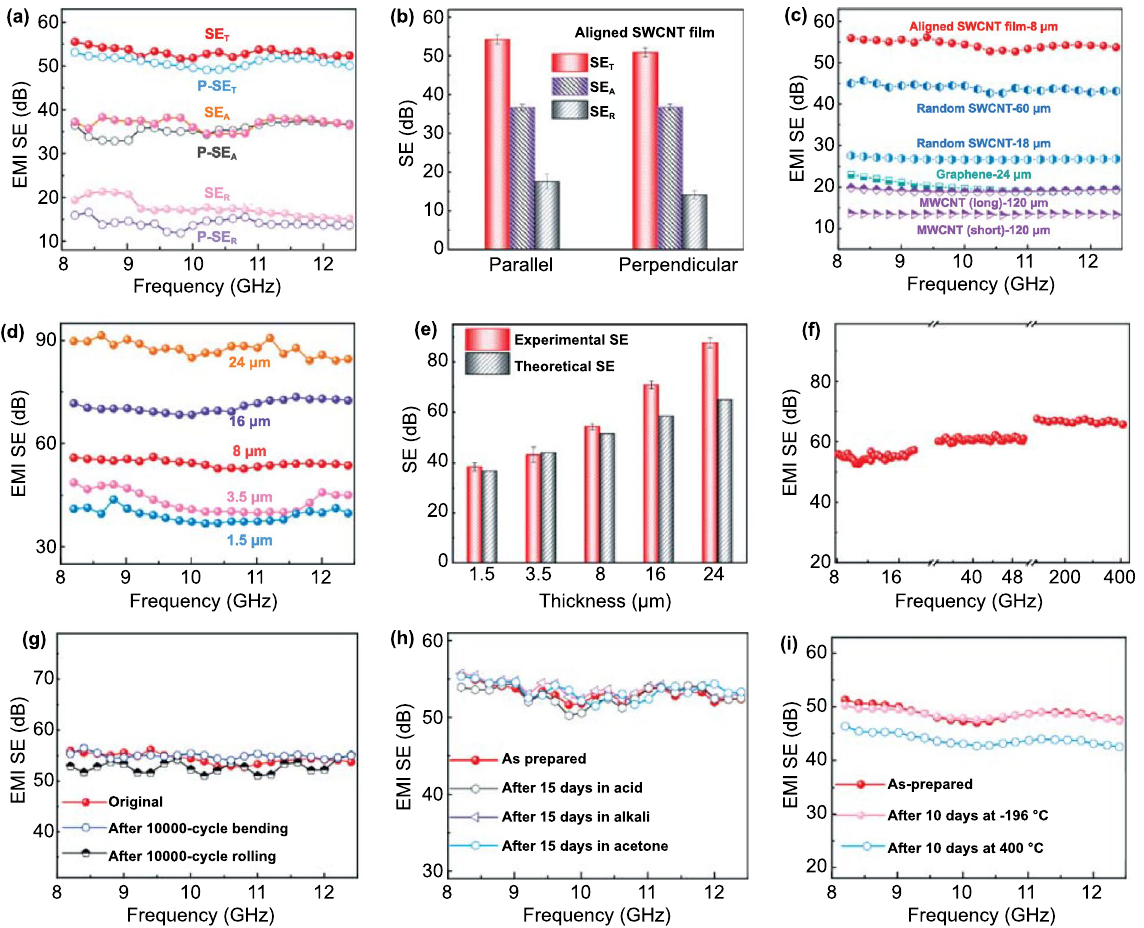
Fig. 3 EMI shielding performance of the aligned SWCNT films. EMI Shielding performance a in the X-band and b at 10 GHz of the 8 µm thick aligned SWCNT films in different directions with respect to the electric field direction of incident EM waves. c EMI SE of aligned SWCNT films, and vacuum-filtrated random network SWCNT buckypaper, rGO film, and different aspect ratios of MWCNT buckypapers. d EMI SE in the X-band at various thicknesses for the SWCNT films. e Experimental EMI SE at 10 GHz of the aligned SWCNT films with various thick- nesses, as comparison to the theoretical EMI SE of a homogeneous shield. f The experimental measured EMI SE values of the 8 µm thick aligned SWCNT films in ultra-broadband frequency range. g EMI SE of the films after 10,000 cycle bending and rolling in the whole X-band frequency range. EMI SE of the as-prepared SWCNT films h before and after strong acid, alkali, or acetone immersion treatments and i before and after low-/high-temperature treatments. The EMI SE is nearly unchanged after long-term storage in harsh environments, revealing a